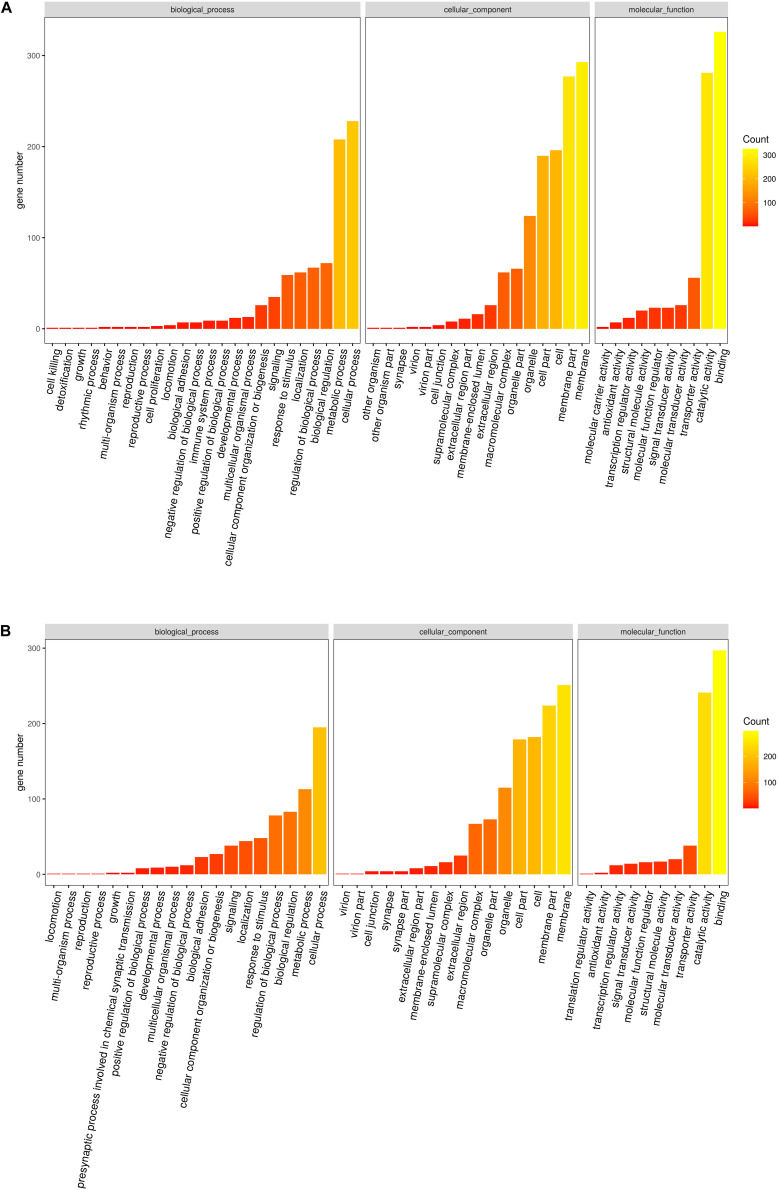
(A) Statistically common enriched Gene Ontology (GO) terms between foot muscle and mantle tissues for the up-regulated unigenes. (B) Statistically common enriched Gene Ontology (GO) terms between foot muscle and mantle tissues for the down-regulated unigenes.